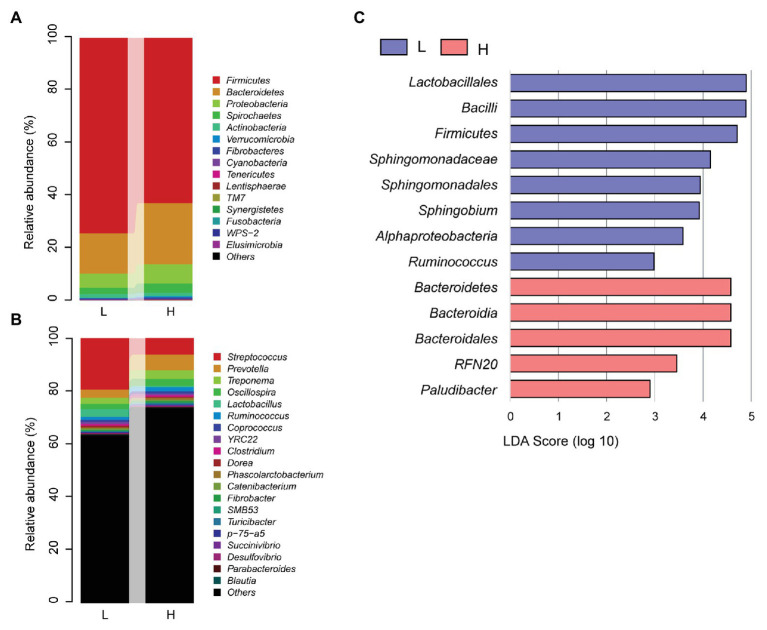
Microbial profiles at the phylum and genus level. (A) Barplot of relative abundance at the phylum level and (B) genus level for the L and H groups. The y-axis represents the relative abundance of each phylum for the two groups. (C) Linear discriminant analysis (LDA) score for discriminated genera in the L and H groups. The LDA score is calculated by LEfSe. The value suggests that it is increased in the two groups (p < 0.05, Wilcoxon rank-sum test, LDA > 2).